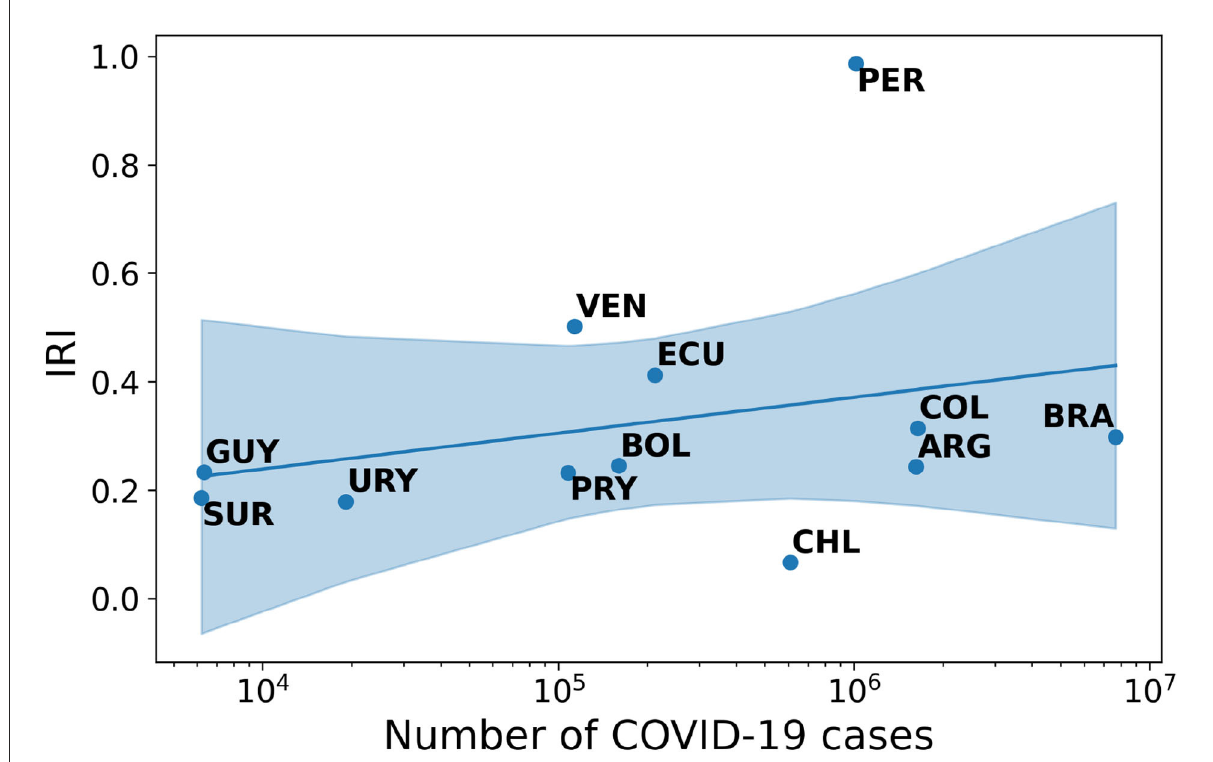
FIGURE4 Correlation between IRI and number of COVID-19 cases in South